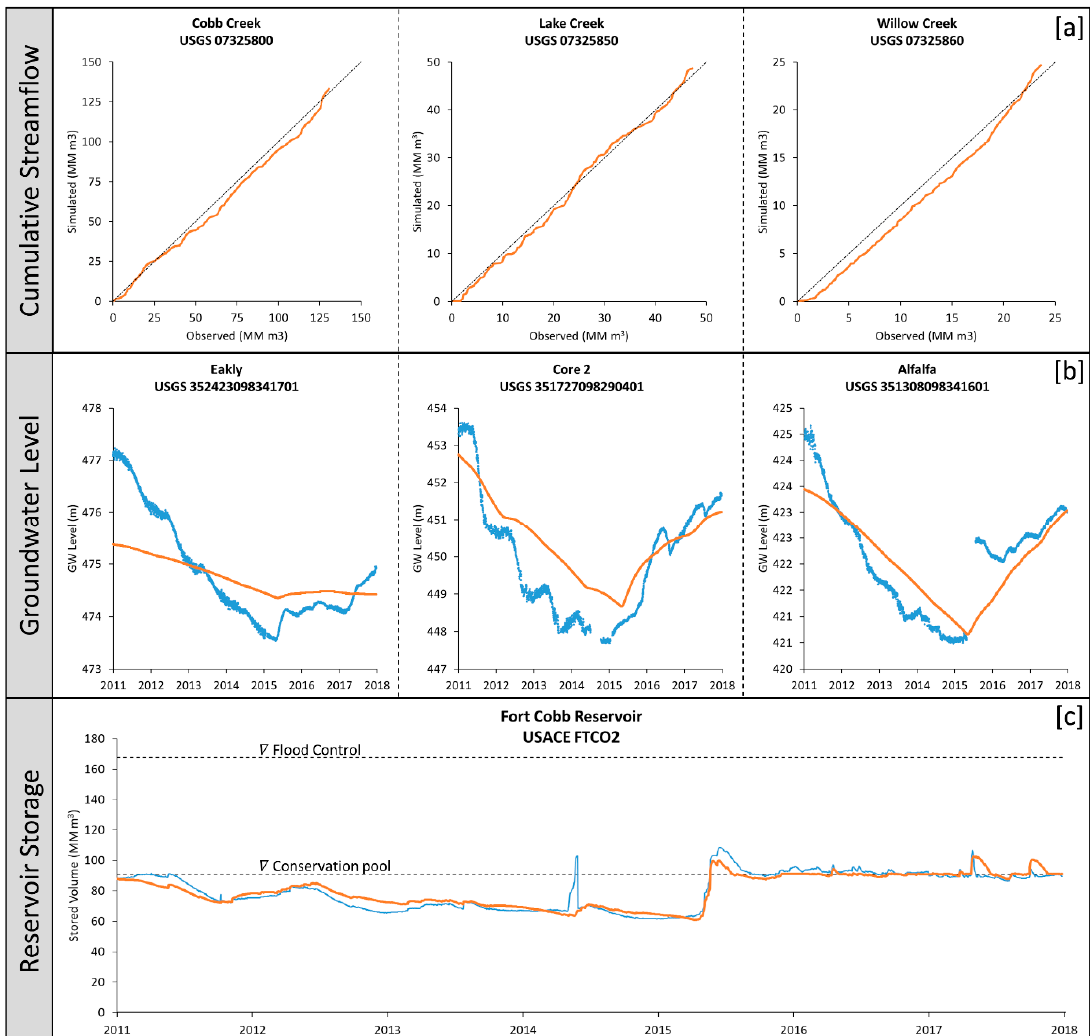
Figure 5. Calibration results (2011–2017). ( a ) Observed vs simulated (orange solid line) cumulated streamflow at Lake, Cobb, and Willow Creek monitoring gauges; ( b ) daily observed (blue dots) and simulated (orange line) groundwater levels at Eakly, Core2, and Alfalfa monitoring wells; ( c ) daily observed (blue solid line) and simulated (orange solid line) reservoir volume storage.